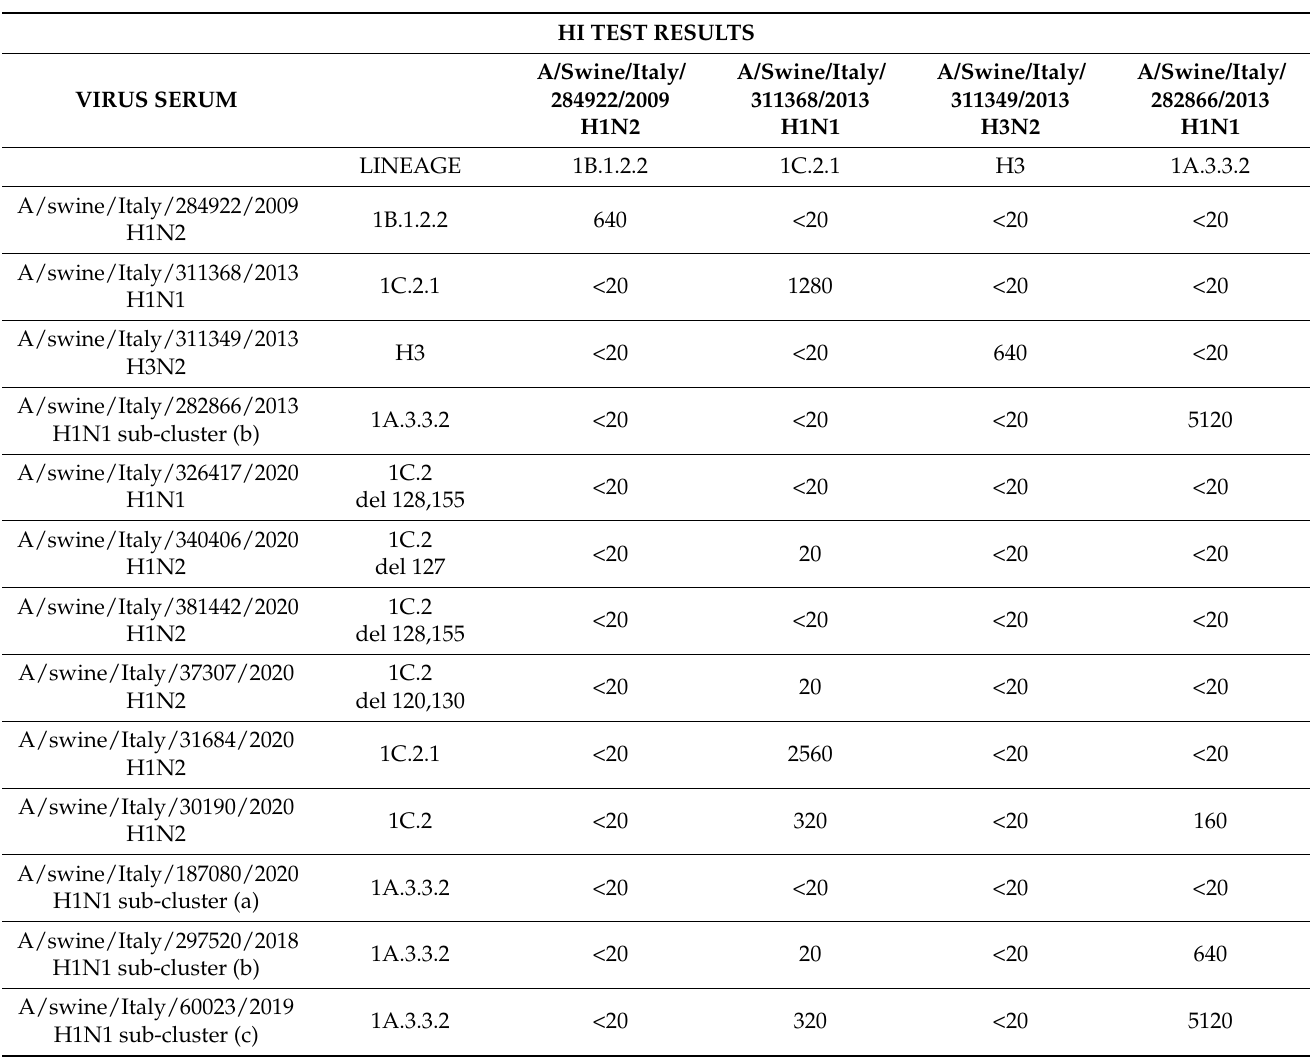
Table 5. HI titers of selected strains using Italian pig hyperimmune sera produced against representa- tive Italian 1B.1.2.2, 1C2.1, H3, and 1A.3.3.2 swIAV strains. These hyperimmune sera exhibit HI titers against homologous viruses that ranged between 1:640 and 1:5120. HI TEST